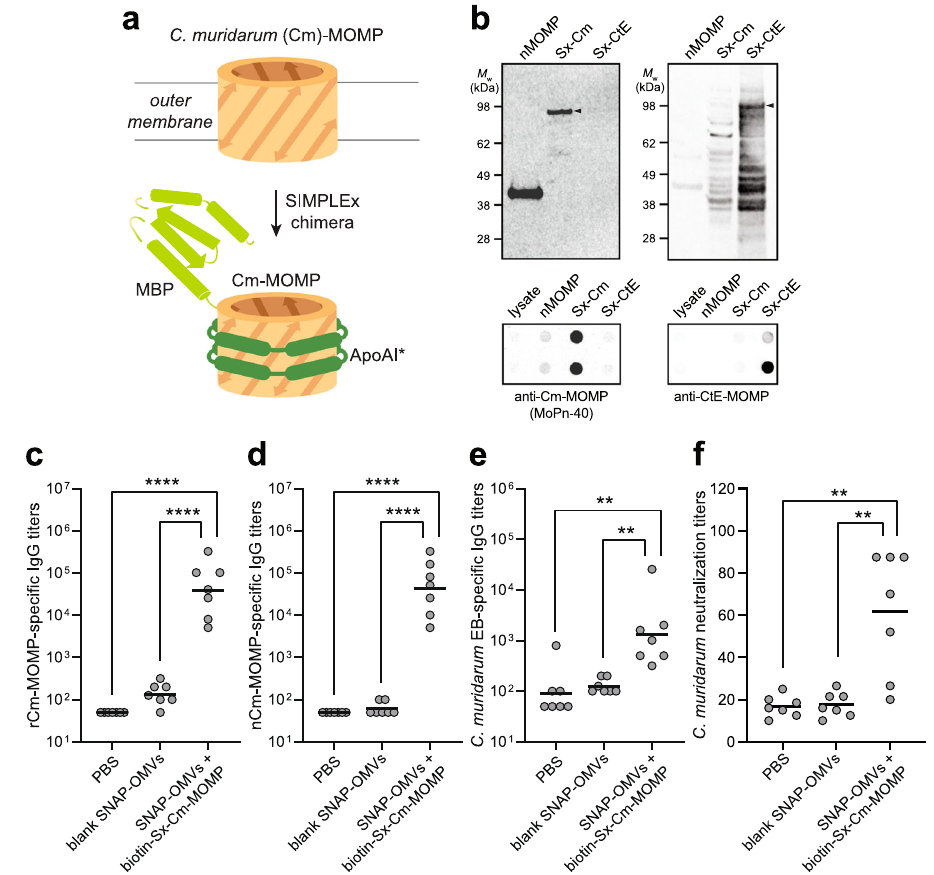
Fig. 5 | SNAP-OMVs decorated with biotinylated Sx-Cm-MOMP elicit neu- tralizing IgGs.a Schematicof SIMPLExstrategyforconvertingintegralmembrane proteins into water-soluble proteins that can be expressed at high titers in the cytoplasmofhostcells.Here,the β -barreloutermembraneproteinCm-MOMPwas fused at its N-terminus with E. coli maltose-binding protein (MBP) and at its C-terminuswithtruncatedApoAI(ApoAI*).StructuralanalysisindicatesthatApoAI* adoptsabelt-likeconformationaroundthemembranehelicesofproteinstowhich it is fused, effectively shielding these highly hydrophobic segments from water 56 . Schematiccreated with BioRender.com. ( b , leftblot) Antigenicity of Sx-Cm-MOMP construct evaluated by immunoblot analysis using mAb MoPn-40. Native Cm- MOMP (nCm-MOMP) and Sx-CtE-MOMP served as positive and negative controls, respectively. ( b , right blot) The latter construct was detected with commercial antibody speci fi c for CtE-MOMP, which did not react with Sx-Cm-MOMP or nMOMP. Expected location of full-length SIMPLEx fusion proteins are denoted by blackarrows.Molecularweight(